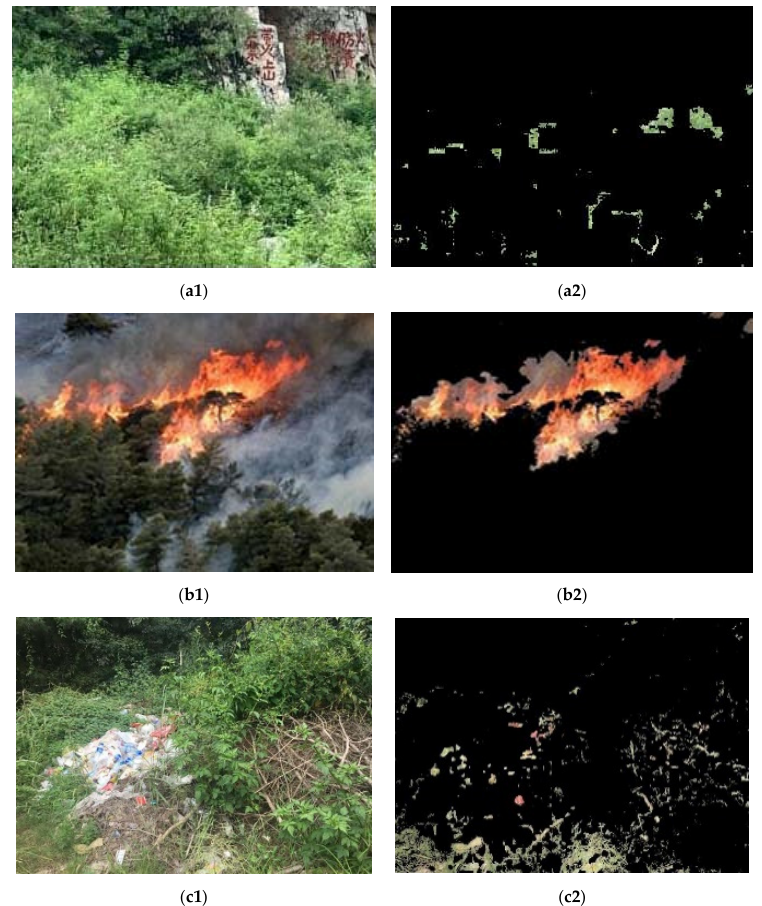
Figure 5. Extraction results via YCbCr color space: ( a1 ) Forest image without fire; ( a2 ) extraction results of forest image without fire; ( b1 ) forest image with fire; ( b2 ) extraction results of forest image with fire; ( c1 ) forest image with fire-like interference; ( c2 ) extraction results of forest image with fire-like interference.